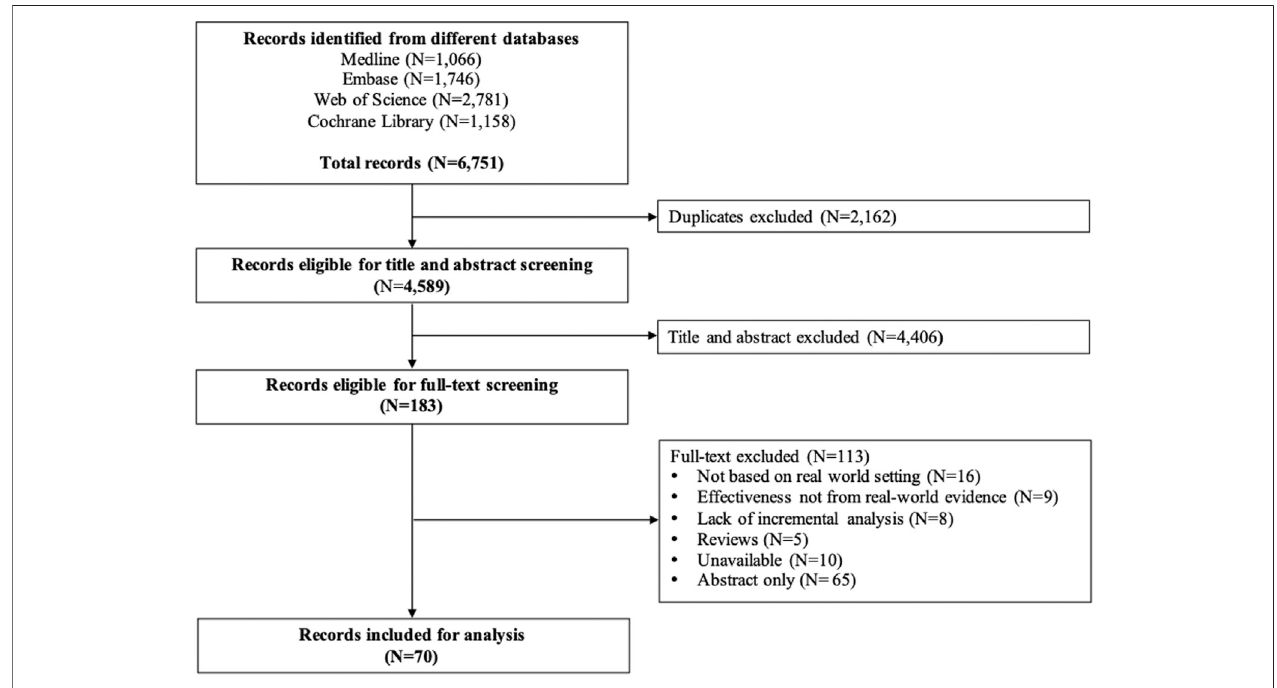
FIGURE 1 | Flowchart of publication